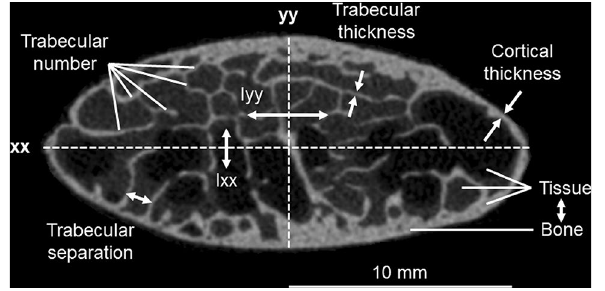
Figure 6. Illustrative summary of all evaluated cross-sectional morphological